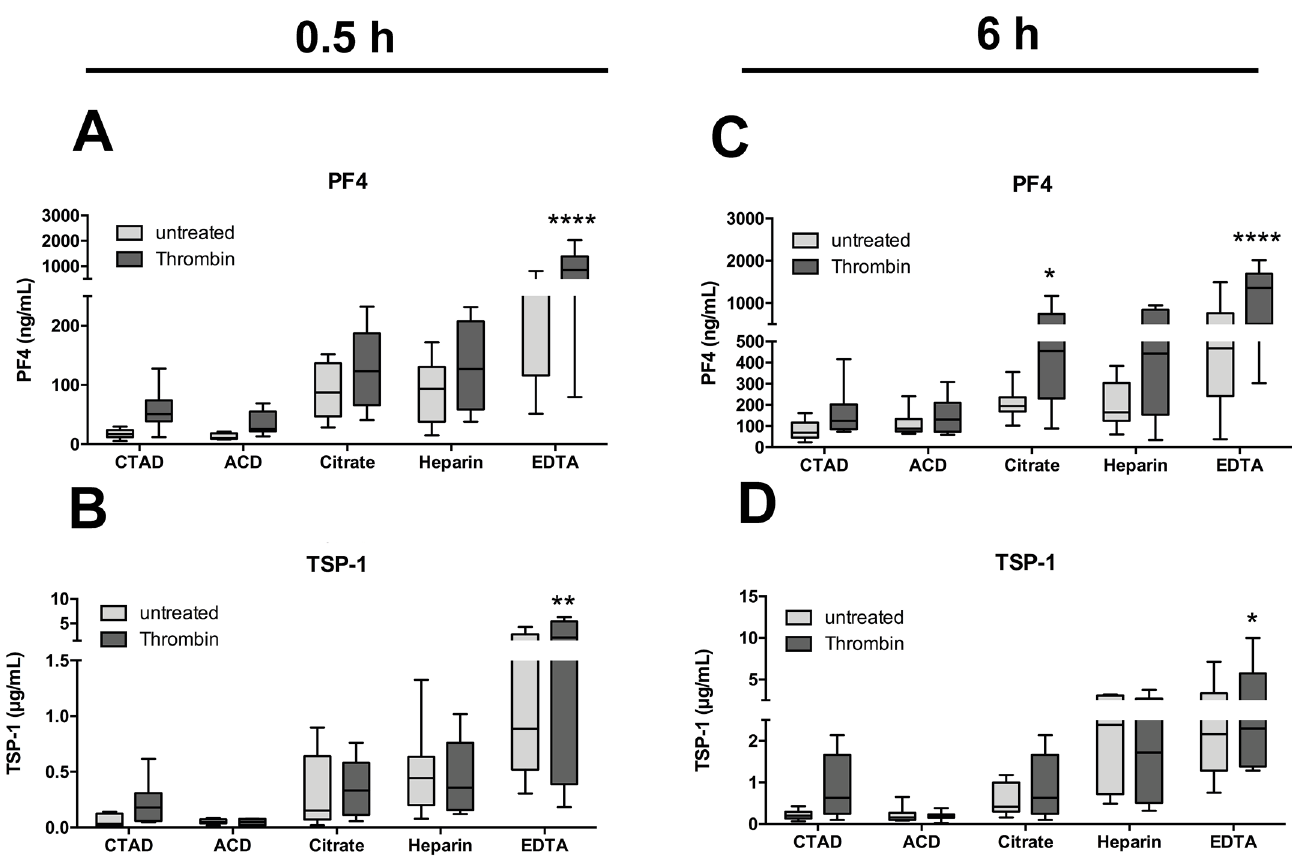
Fig 5. Effect of in vitro platelet activation on concentration of plasma factors. Blood of 8 healthy donors was anticoagulated with CTAD, ACD, citrate, heparinor EDTA (grey bar) and stimulatedwith the platelet activator thrombin (dark grey bar) at a submaximal dose for 0.5 h and 6 h at room temperature. Subsequently, plasma was preparedand analyzedfor PF4 (A, C) and TSP-1 (B, D) levels. Significantdifferences were analyzedusing two-way ANOVA with Bonferroni correctionand were depictedas * p < 0.05, ** p < 0.01, *** p < 0.001, and **** p < 0.0001 (in comparisonto untreated).